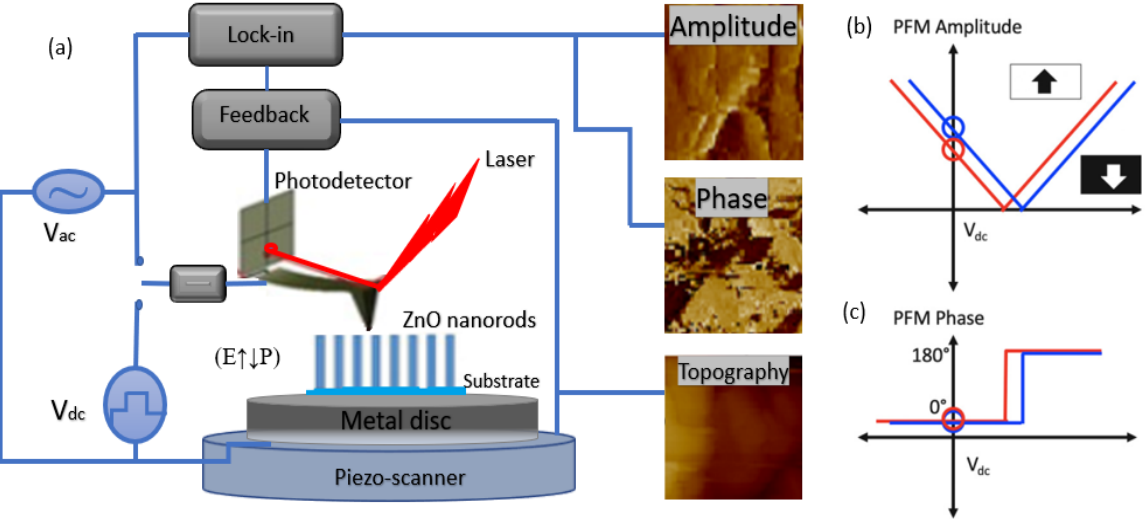
Figure 12. ( a ) Schematic of PFM measurement set-up with topography, phase, and amplitude images. The images show phase angle is either 0° or 180°, indicating that the polarization vector pointed either downward to the bottom electrode or upward to the samples’ surface, while ( b ) and ( c ) are the local hysteresis loops as a function of V dc to the ZnO NRs sample for up (red line) and down (blue line) domains. Reprinted with permission form ref. [89]. Copyright 2021 Elsevier. Reprinted with permission from ref. [152]. Copyright 2021 AIP Publishing.